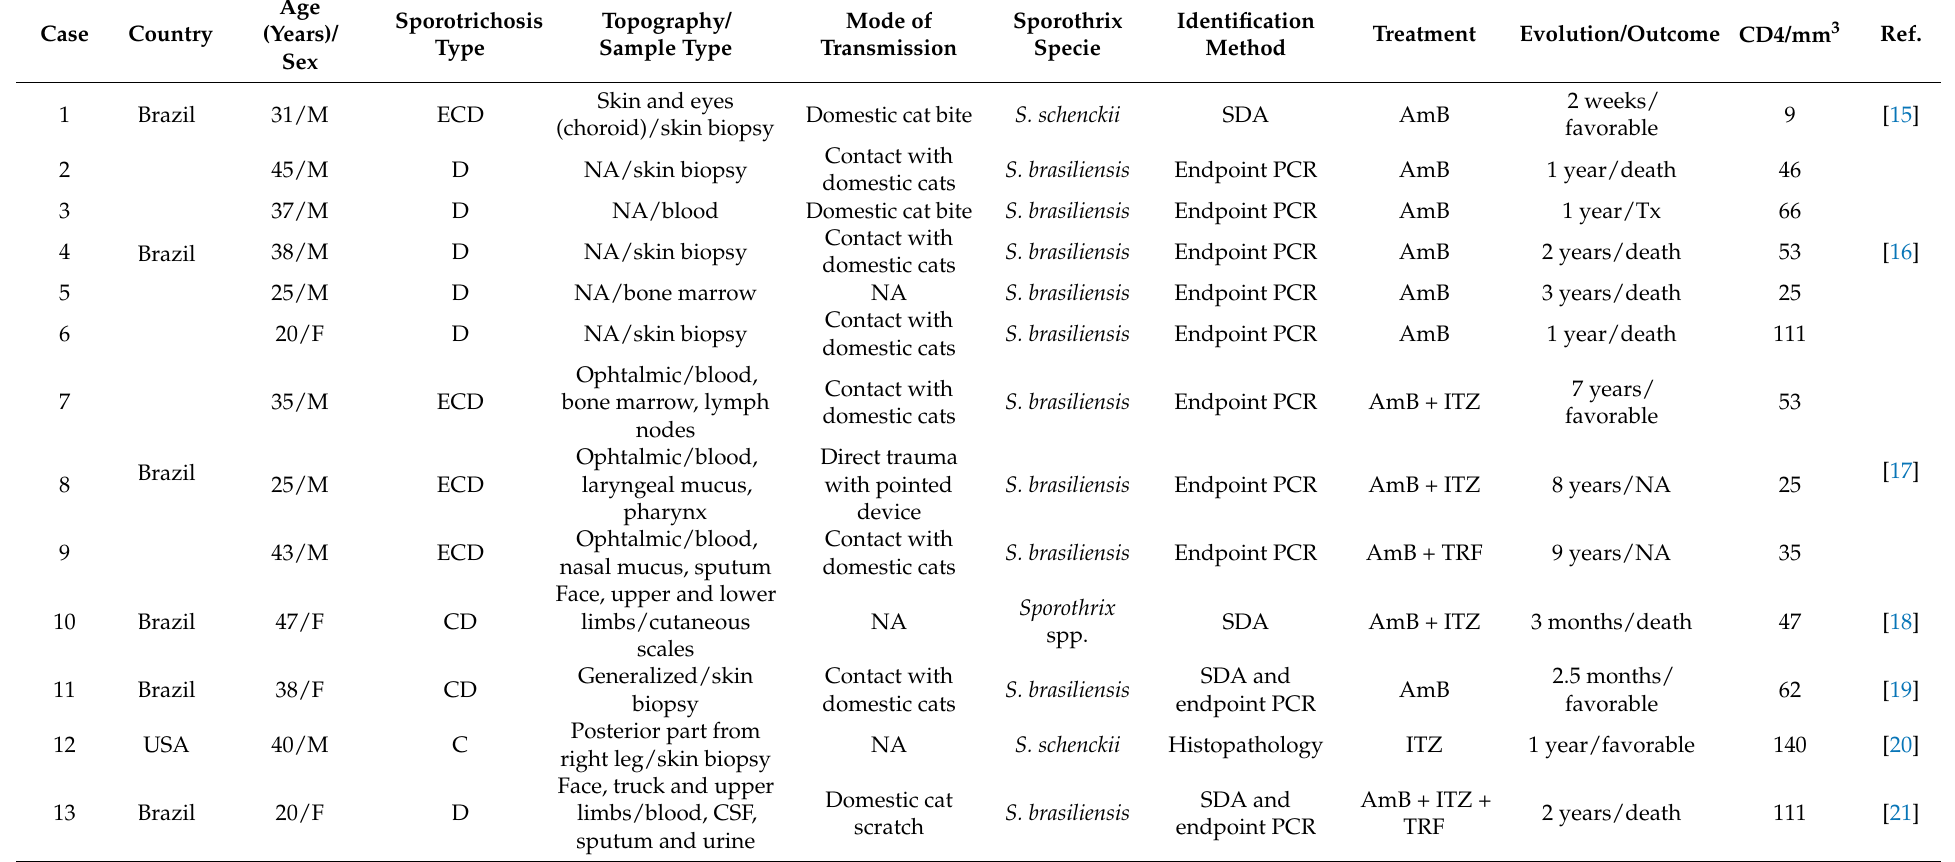
Table 1. Cases of Sporotrichosis in patients with HIV